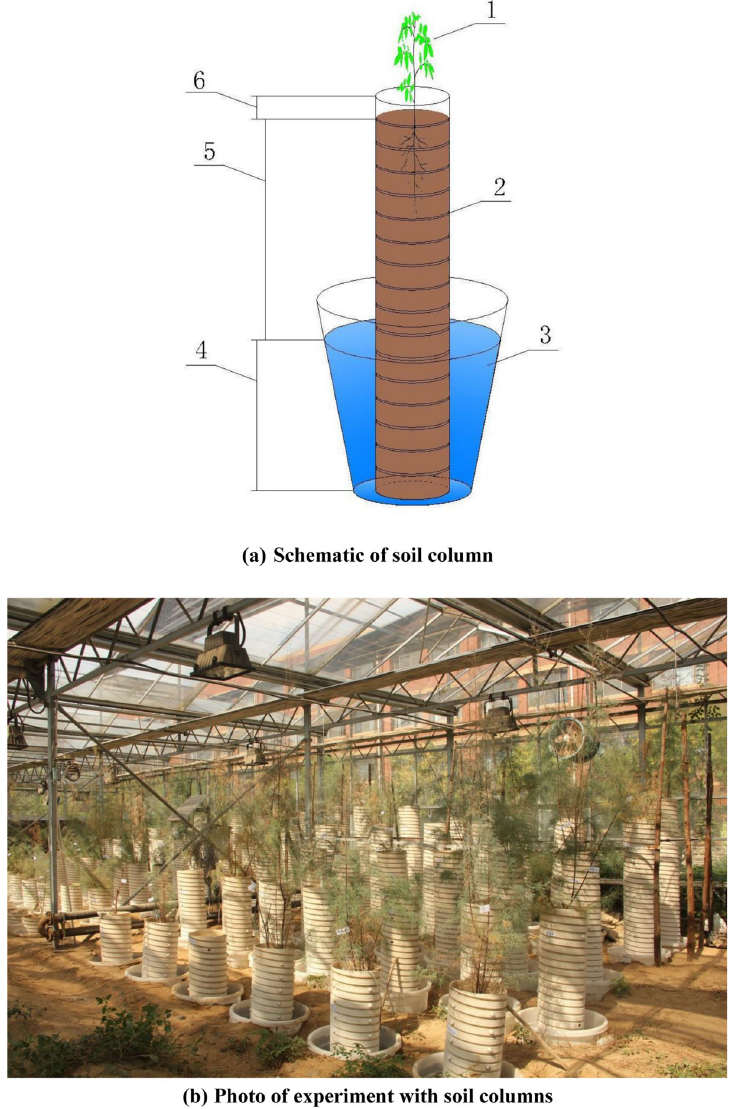
area at 0.55 m. 5, Groundwater depths (0.3m-1.8 m); 6, Interstice layer of 0.03